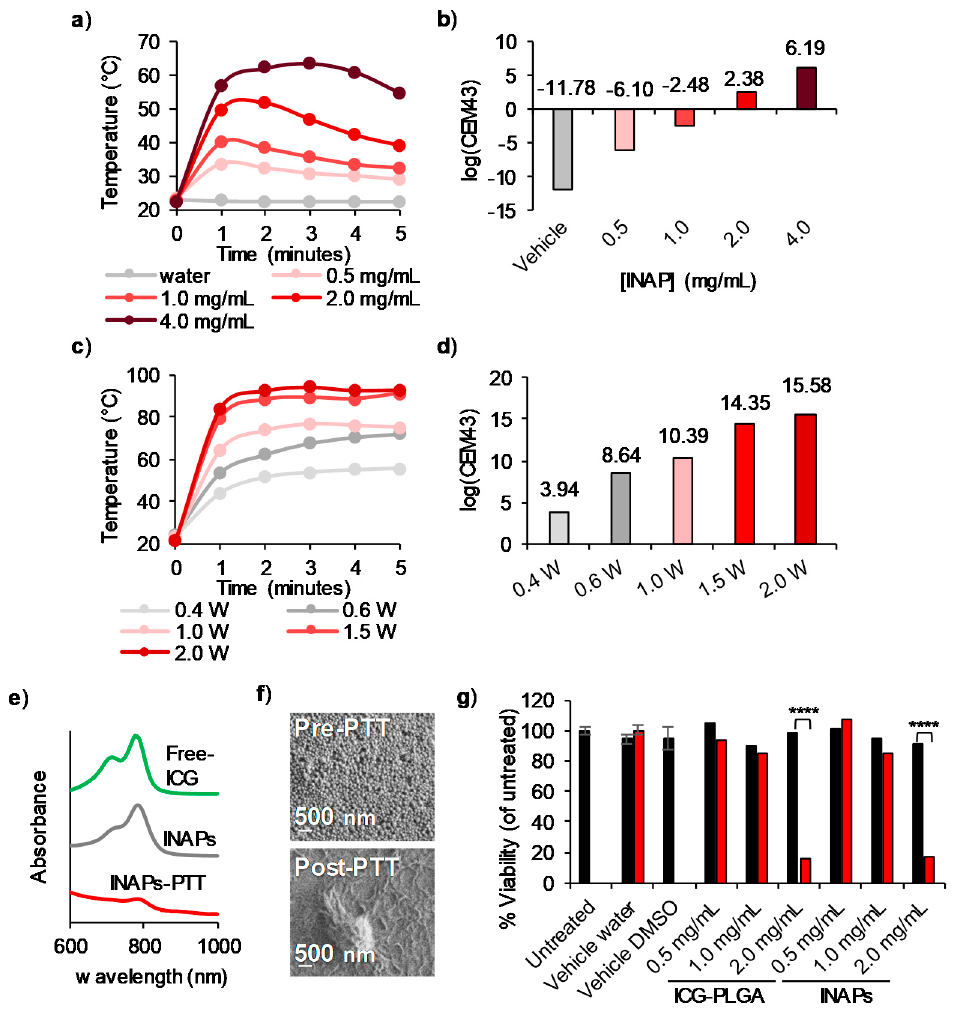
Figure 3. The photothermal heating of INAPs decreases melanoma cell viability in vitro. ( a ) Time– temperature heating curves at 1-min intervals and ( b ) Thermal doses expressed in log(CEM43) of varying concentrations of INAPs (0.5–4 mg / mL) exposed to a 0.8 W NIR laser for 5 min demonstrate concentration-dependent heating. ( c ) Time–temperature heating curves at 1-min intervals and ( d ) thermal doses expressed in log(CEM43) of 4 mg / mL INAPs exposed to varying NIR laser powers (0.4–2 W) for 5 min demonstrate laser power-dependent heating. ( e ) UV-Vis-NIR spectroscopy of free ICG (green), INAPs before (gray), and after (red) exposure to 0.8 W NIR laser for 5 min show lower ICG presence. ( f ) SEM images of INAPs show changes in INAP morphology before (Pre-PTT, mag. 50,000 × , curr 25 pA) and after (Post-PTT, mag. 50,000 × , curr 13 pA) exposure to a 0.8 W NIR laser for 5 min. ( g ) SM1 melanoma cells were suspended in PBS and treated with INAPs or ICG-PLGA at varying concentrations or controls in the presence (red) or absence (black) of the laser. Cells were subsequently re-plated in media and incubated at 37 ◦ C for 24 h, after which the Cell Titer-Glo ATP assay was performed and determined a decrease of the SM1 cell viability in the presence of the laser.